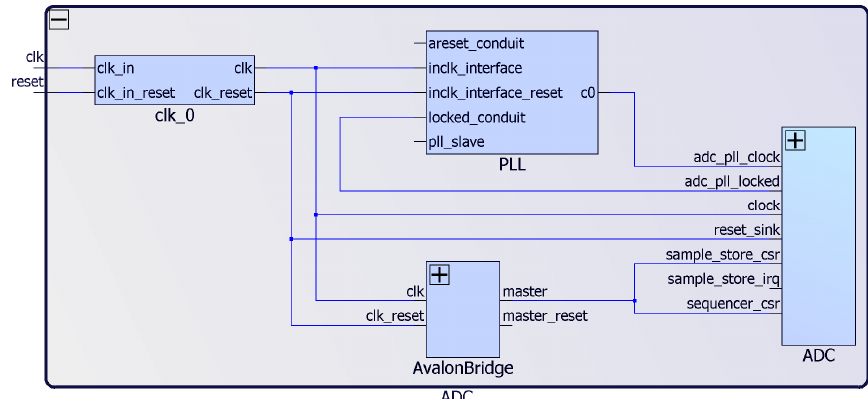
Figure 19. Schematic of the ADC design implementation.